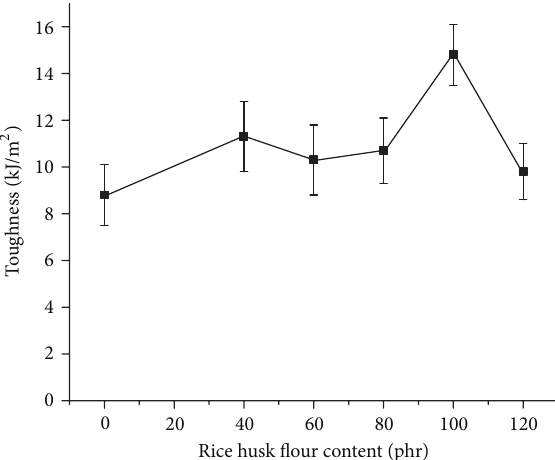
Figure 5: Effect of PP-g-MA content on toughness of PP/RHF (100/100) composites.